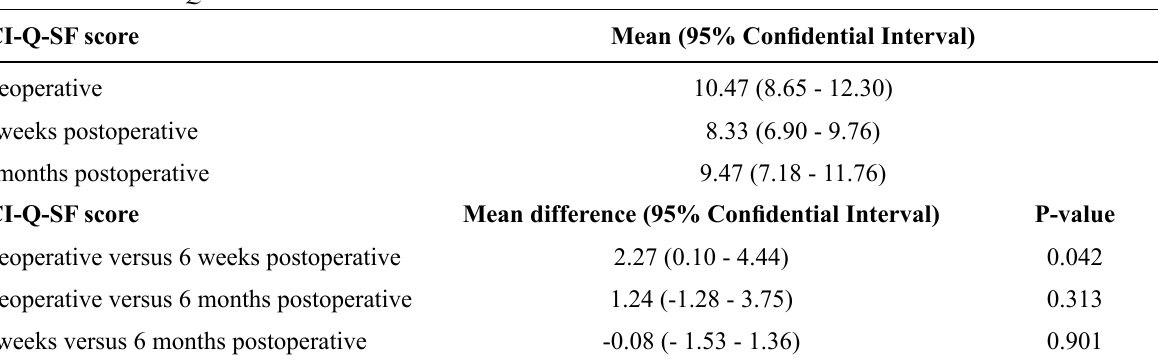
Table 3 - Results ICI-Q-SF